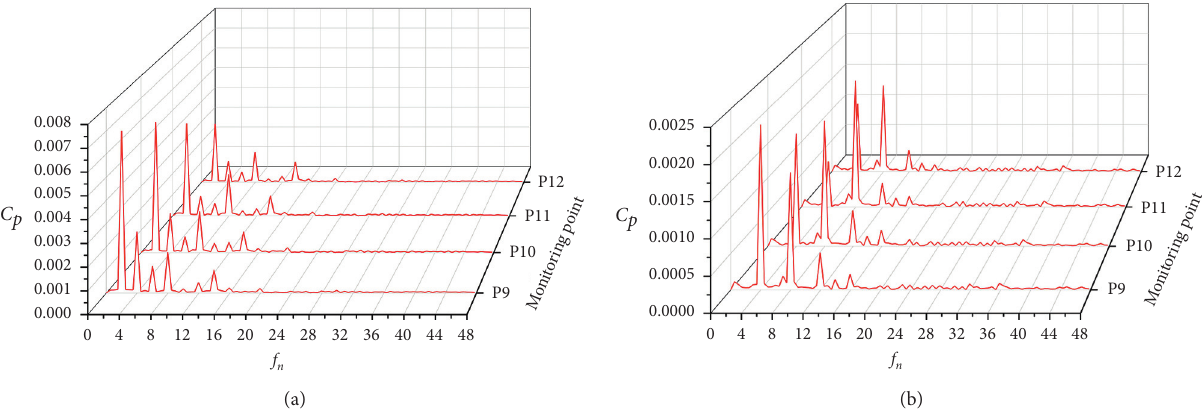
Figure 21: Frequency domain of each monitoring point at the guide vane outlet ( Q � Q